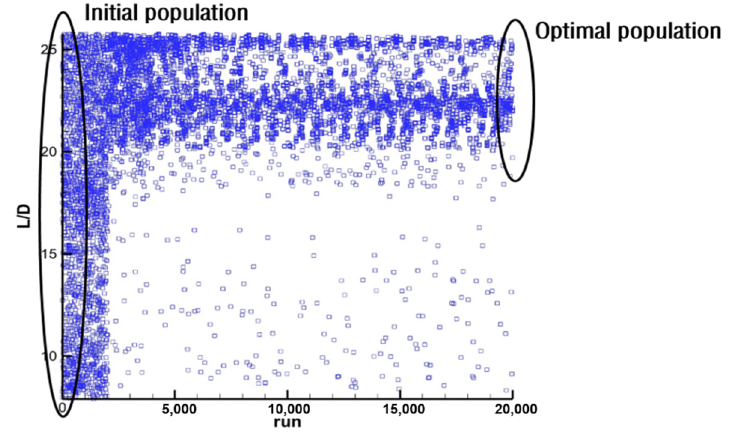
Figure 18. The variation of the constraints in the optimization process.